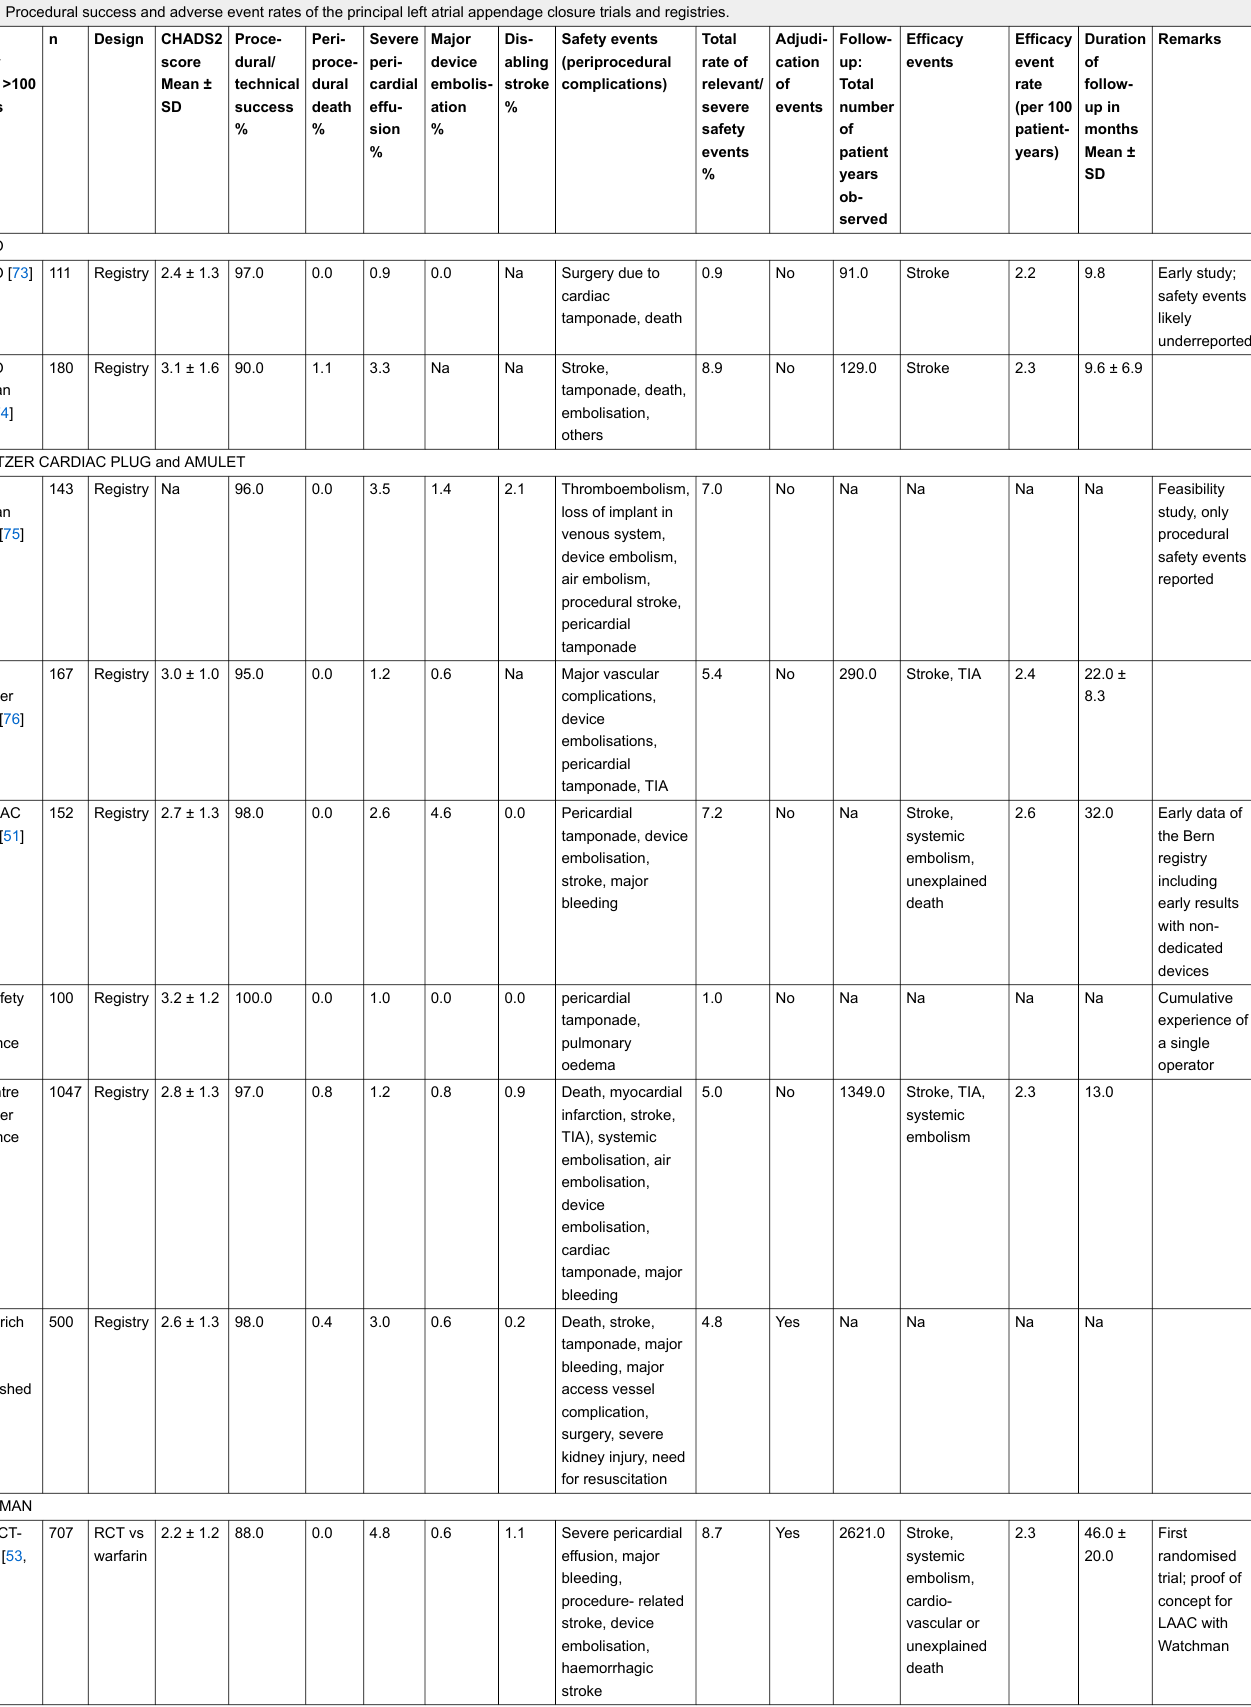
Table 1: Procedural success and adverse event rates of the principal left atrial appendage closure trials and registries. Trial /